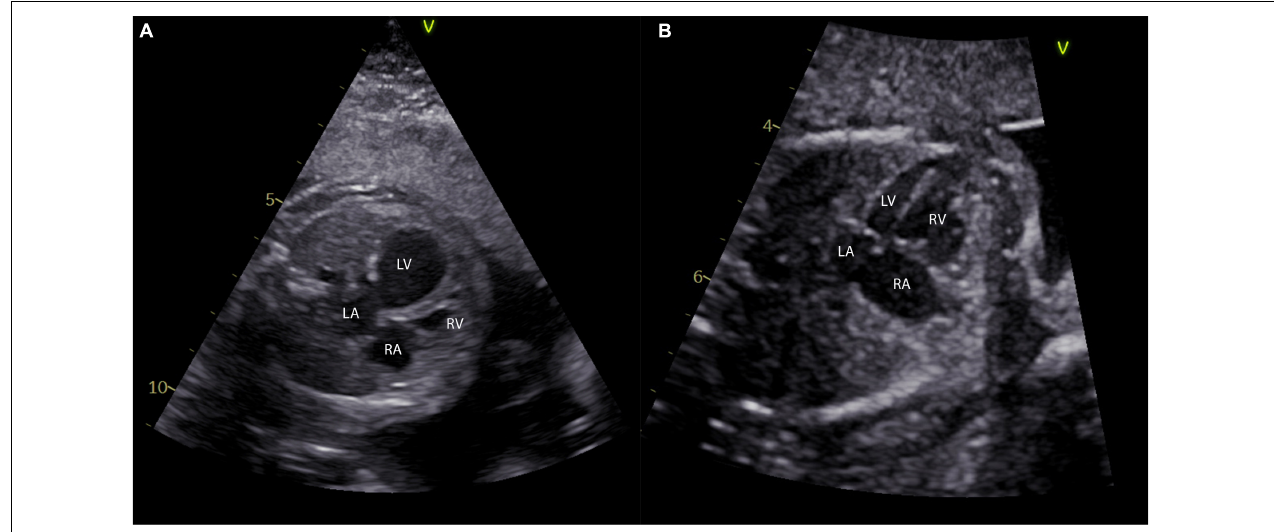
FIGURE 1 | Different phenotypes of left ventricular hypoplasia in the fetus. (A) A four-chamber view of a fetus with 24 weeks and critical aortic stenosis is shown with a severely dilated left ventricle. Panel (B) shows a four-chamber view of a fetus at 27 weeks with a long and skinny, but apex forming left ventricle. LA, left atrium; LV, left ventricle; RA, right atrium; RV, right